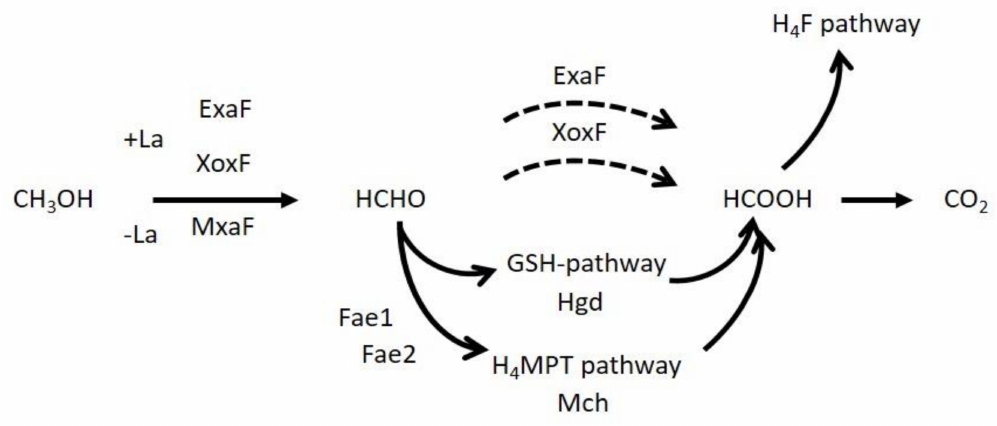
Figure 1. A schematic of the methylotrophy pathway. Dashed lines indicate possible direct